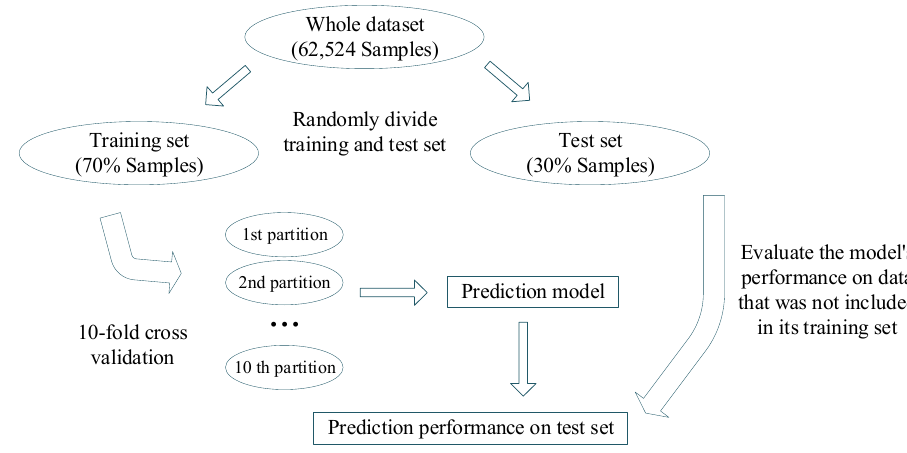
Figure 3. Scheme of the training and validation process.